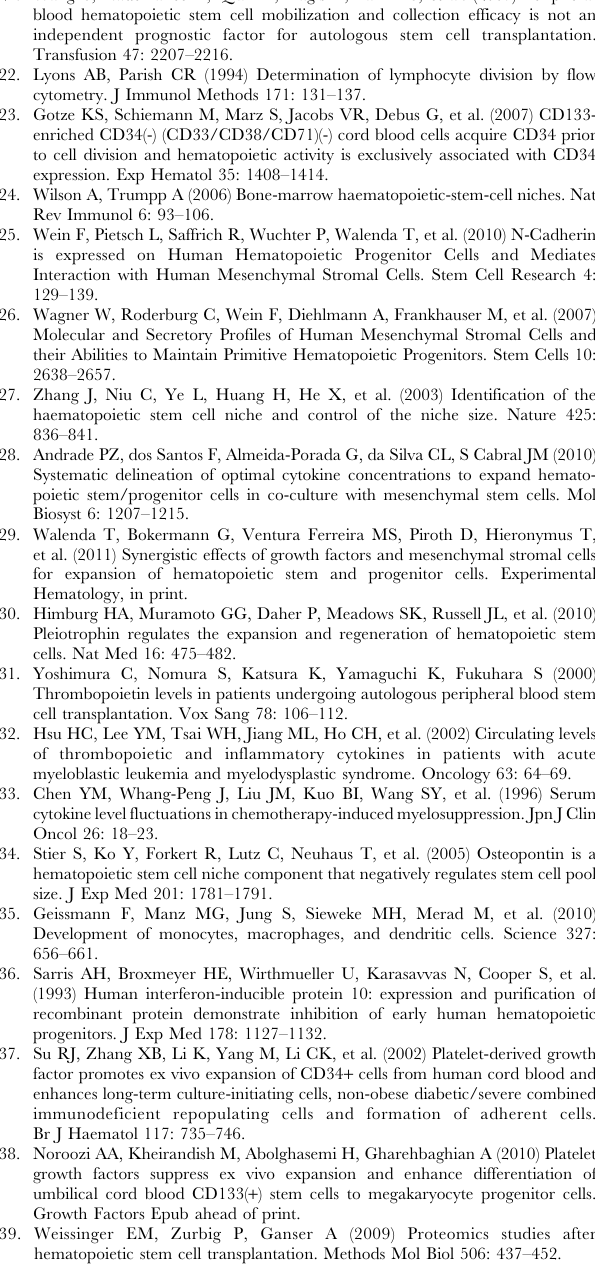
Figure S2 Heat map of all 174 human proteins repre- sented by the Cytokines Antibody Array. Figure S3 Effects of PDGF on in vitro expansion of HPC. CD34 + cells were stained with CFSE and cultured for seven days in culture medium with TPO, FGF and SCF supplemented with different concentrations of PDGF. PDGF did not affect prolifer- ation of HPC without stromal support (A), whereas addition of 100 ng/mL PDGF slowed cell division of HPC in co-culture with MSC (B; n= 4). CFU potential was not consistently affected by addition of PDGF (C, D; n= 4; error bars represent SD). (TIF)